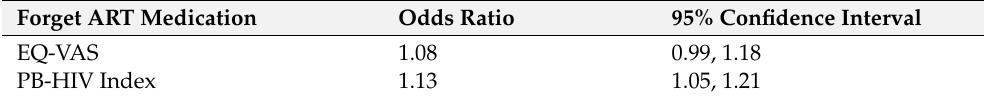
Table 5. Odds ratio and 95% CI on self-report adherence to medication and EQ-VAS and PB-HIV Index. Forget ART Medication